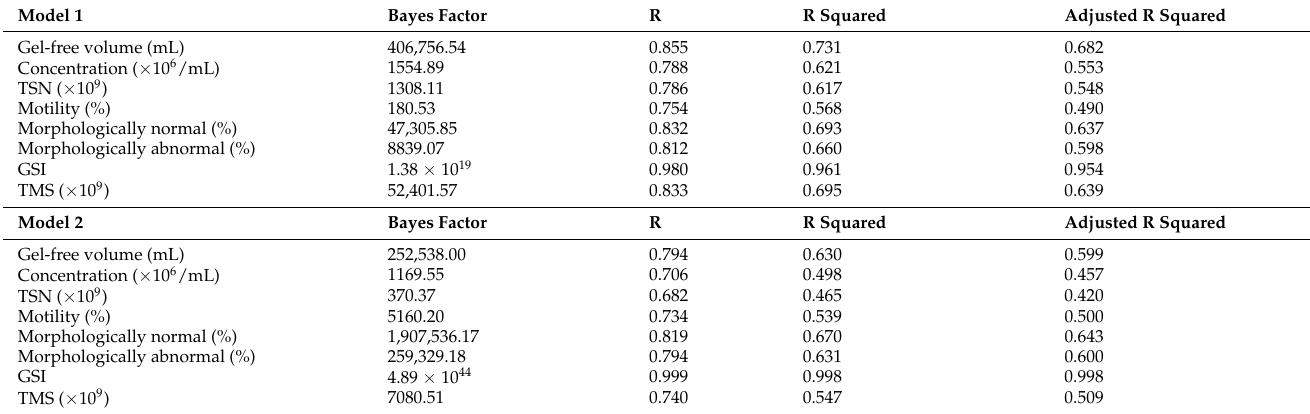
Table 4. Bayes Factor Model Summary for model 1 (comprising age and testicular morphometric parameters) and model 2 (comprising age, BW, TTV, and GSI) to predict for sperm output and quality in Miranda donkey breed. Model 1 Bayes Factor R R Squared Adjusted R Squared Gel-free volume